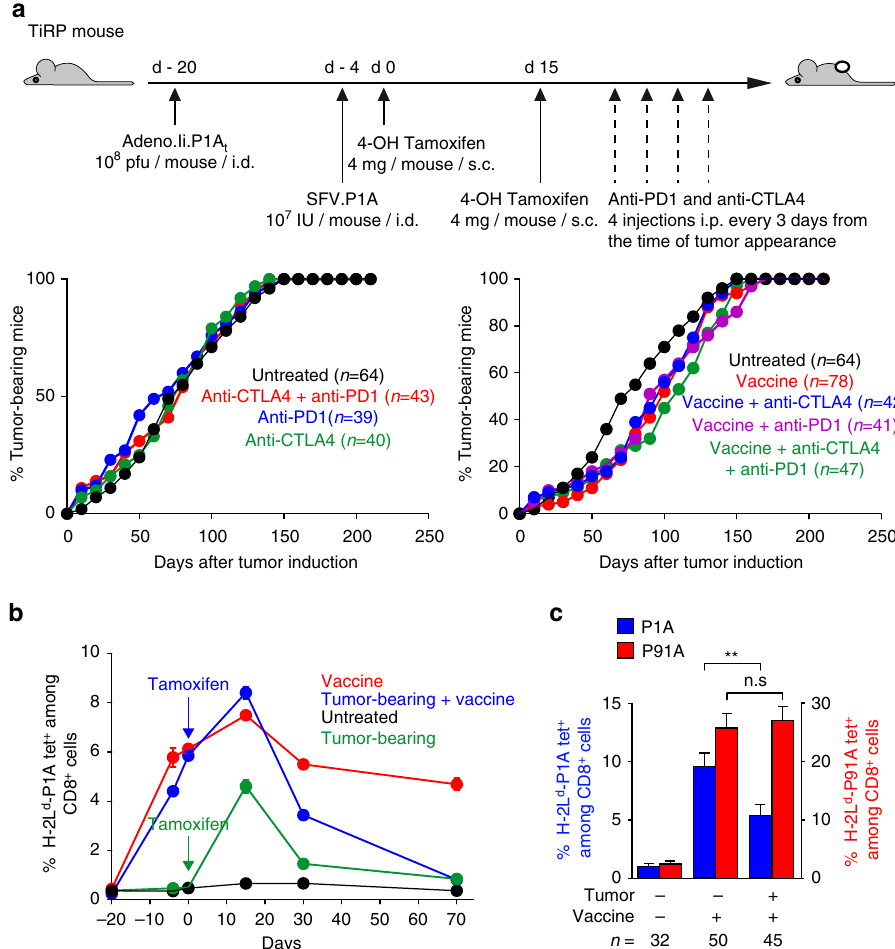
Fig. 1 Induced TiRP tumors resist immunotherapy. a Schedule for tumor induction and immunotherapy. TiRP mice (B10.D2;Ink4a/Arf fl ox/ fl ox ;TiRP +/+ ) injected twice with 4 mg 4OH-tamoxifen on day 0 and 15, were also injected as indicated with anti-CTLA4 (4 × 40 µ g) and/or anti-PD1 (4 × 200 µ g) and/ or a prime/boost vaccine regimen of recombinant adenovirus (Adeno.Ii.P1A t ) and Semliki Forest virus (SFV.P1A) encoding the MAGE-type tumor antigen P1A. Tumor appearance and mice survival were monitored. The fi gure represents the cumulative data of three experiments. b Tumor-bearing TiRP mice and control mice (B10.D2;Ink4a/Arf fl ox/ fl ox mice, which have the same genetic background as TiRP mice but lack the TiRP transgene) were immunized with the P1A vaccine as above, and the P1A-speci fi c CD8 + T-cell response was monitored by FACS in spleen cells stimulated one week with P1A-peptide pulsed spleen cells, using antibodies to CD3 ε and CD8 α , and H-2L d -P1A tetramers. Five mice were analyzed at each time point for each group. c TiRP mice were immunized simultaneously against P1A as above and against the irrelevant H-2L d -restricted antigen P91A (mutated peptide) by intramuscular injections of P91A peptide in AS15 adjuvant 52 one week apart during 1 month. Mice were then treated with 4OH-tamoxifen. At the time of tumor appearance, spleen cells were stimulated one week with P1A or P91A peptide-pulsed spleen cells, and P1A- or P91A-speci fi c CD8 + T cells were quanti fi ed by FACS analysis using the relevant H-2L d tetramers. Results are expressed as mean + s.e.m. Unpaired t -test, two-tailed c , * P < 0.05, ** P <